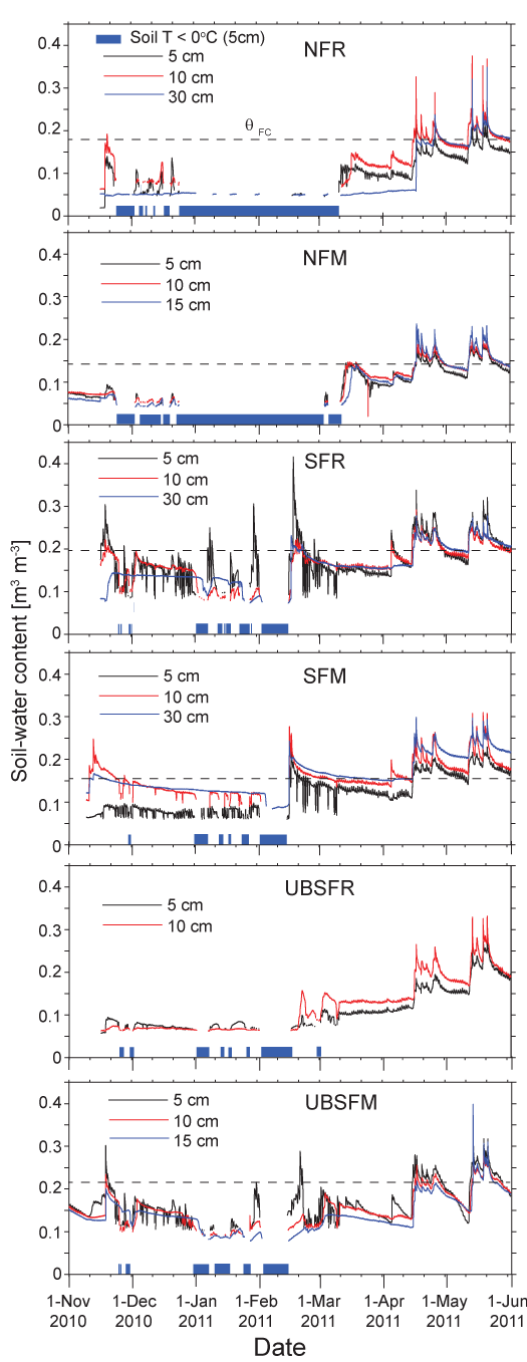
Fig. 7. Automated soil-water content time series from the Decagon 5TE sensors at 1-min temporal resolution. Water content data are omitted when soil temperature is below 0 ◦ C, which is shown by dark blue bars. The dashed line shows the soil-water content at field ) based on measured retention curves (one per site) and capacity ( θ FC van Genuchten (1980) relationships at each plot. No retention curve was measured for UBSFR so no θ value is FC